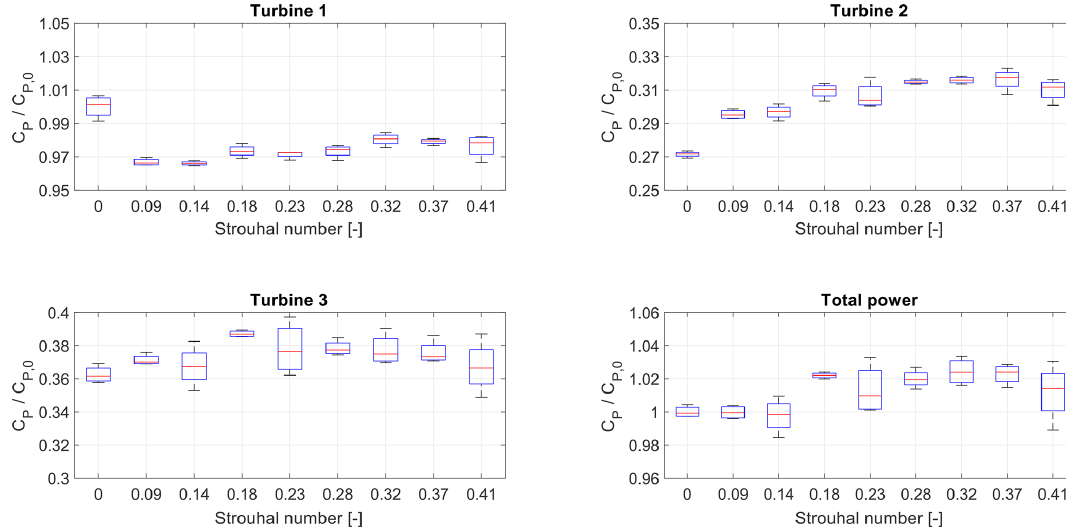
= 1 experiments, for all turbines individually T